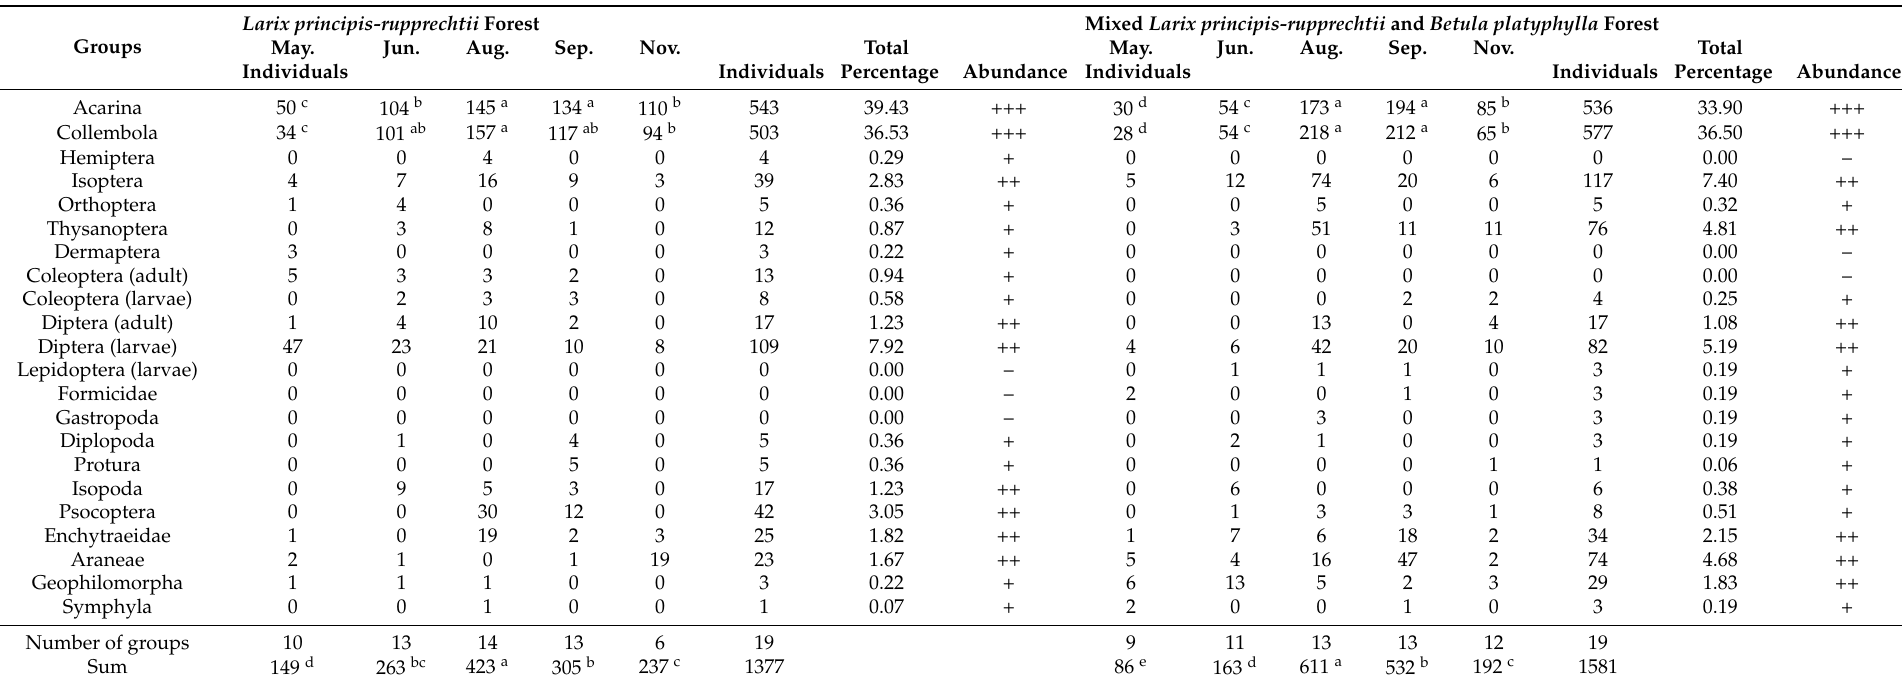
Table 3. Composition of the soil fauna